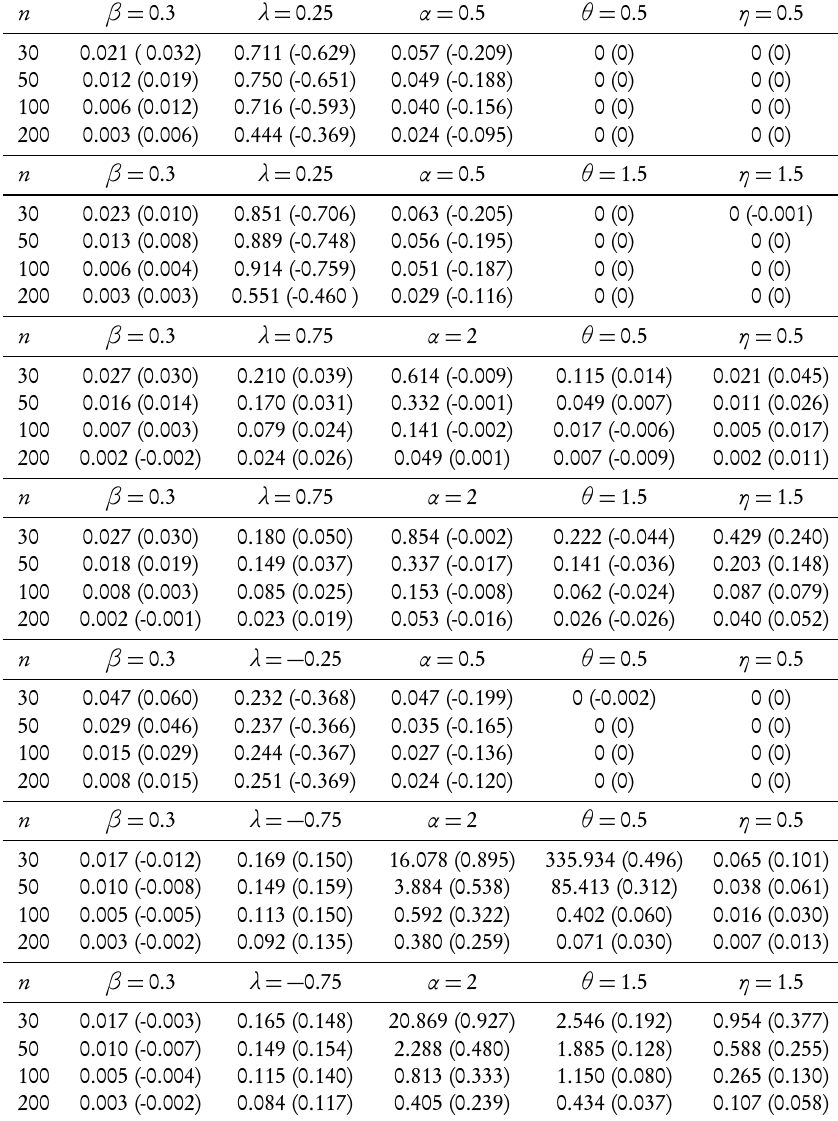
MSE and bias (values in parentheses) of the MLE’s of the parameters β , λ , α , θ and η